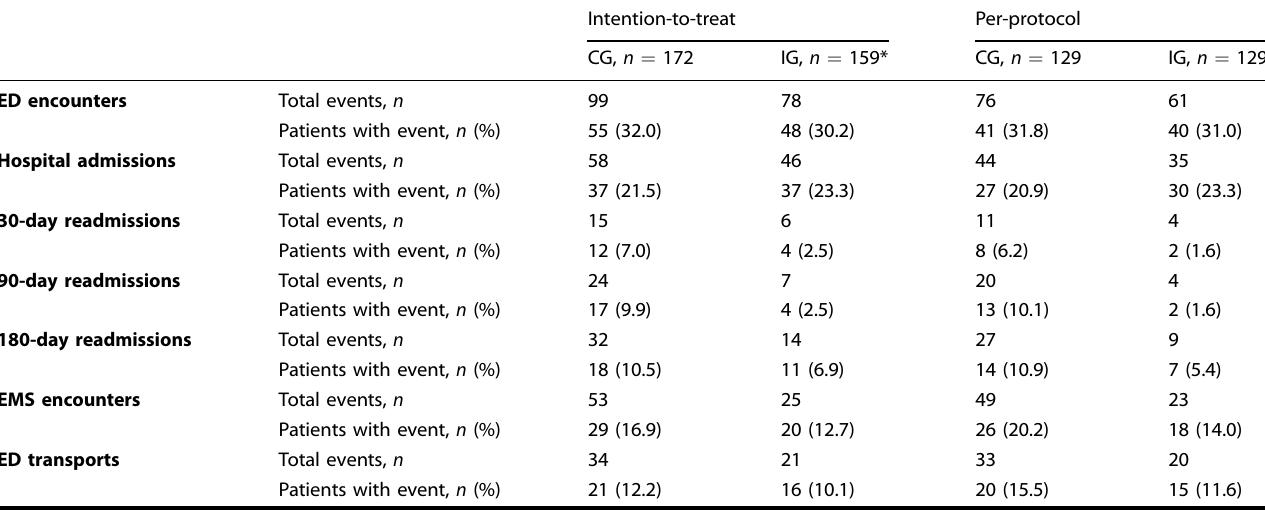
Table 4. Summary of healthcare